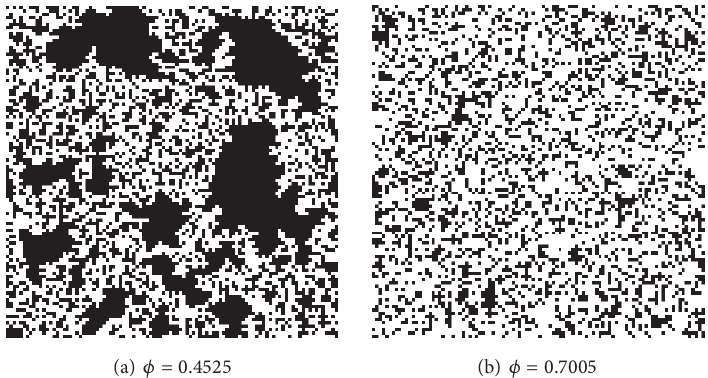
Figure 24: Induced anisotropy in lower porosity geometries comprised of randomly distributed squares.